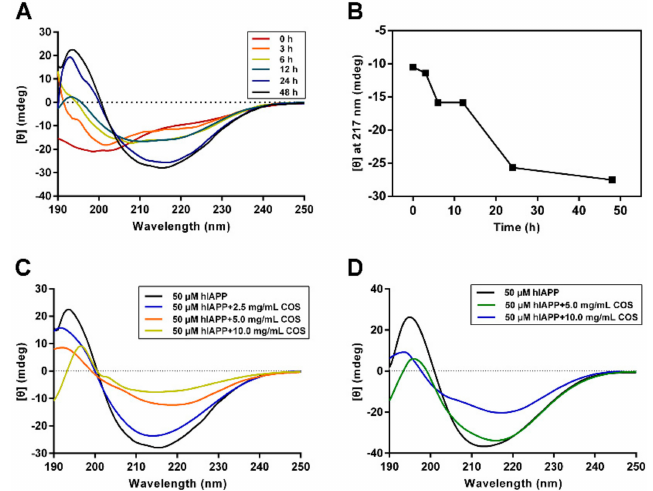
Figure 3. CD analysis of secondary structure transition of hIAPP. ( A ) Structural changes of hIAPP during fibrillation monitored by Far-UV CD. ( B ) Structural changes monitored at 217 nm. ( C ) COS a ff ect hIAPP structure transition during aggregation. COS were used at the concentrations of 0, 2.5, 5.0 and 10.0 mg / mL. ( D ) COS disassemble of hIAPP fibrils at concentrations of 5.0 and 10.0 mg /